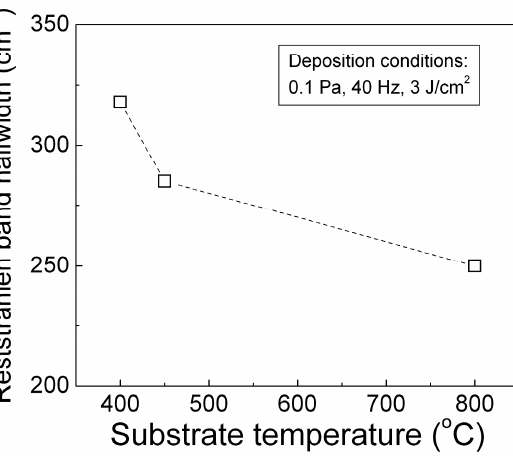
Figure 9. Reststrahlen band half width in p -polarized radiation (Figure 6a) as a function of substrate temperature during AlN film deposition at N 2 pressure of 0.1 Pa, LPF of 40 Hz, and laser fluence of 3 ‒ 4 J/cm 2